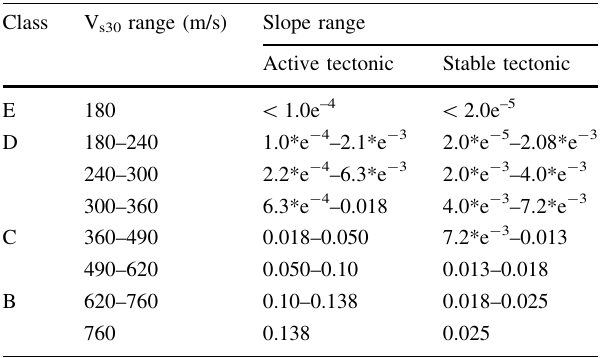
Table 3 Slope range and V s30 value range correspondence table. Source : Wald and Allen (2007)